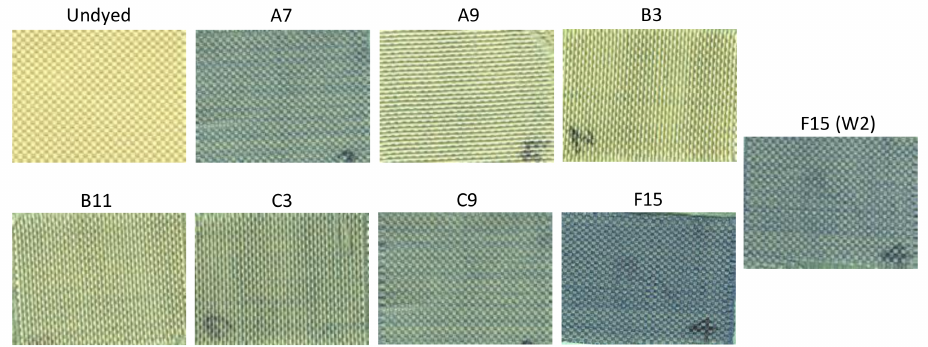
Figure 8. Scanned images comparing dyed samples with the undyed fabric (labels correspond to the